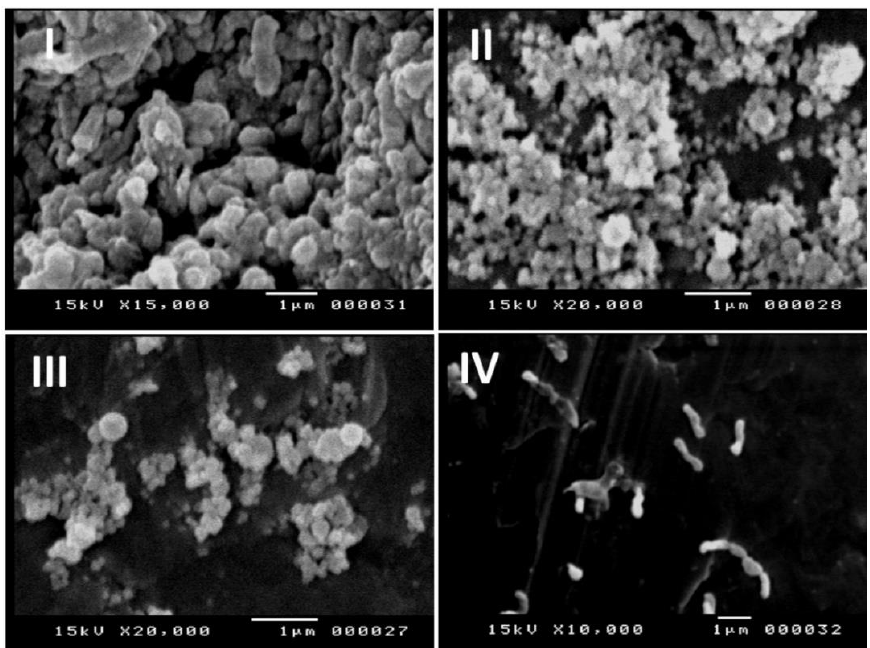
Figure 6. SEM micrographs of the bacteria S. mutans after 24 h of incubation time. The micrographs were made on ( I ) Group A—BIOD; ( II ) Group E—98.5% BIOD with 1.5% cefuroxime; ( III ) Group B—99.5% BIOD with 0.5% ROE-AgNPs; ( IV ) D—98% BIOD with 2% Cefuroxime-ROE-AgNPs nanontibiotic